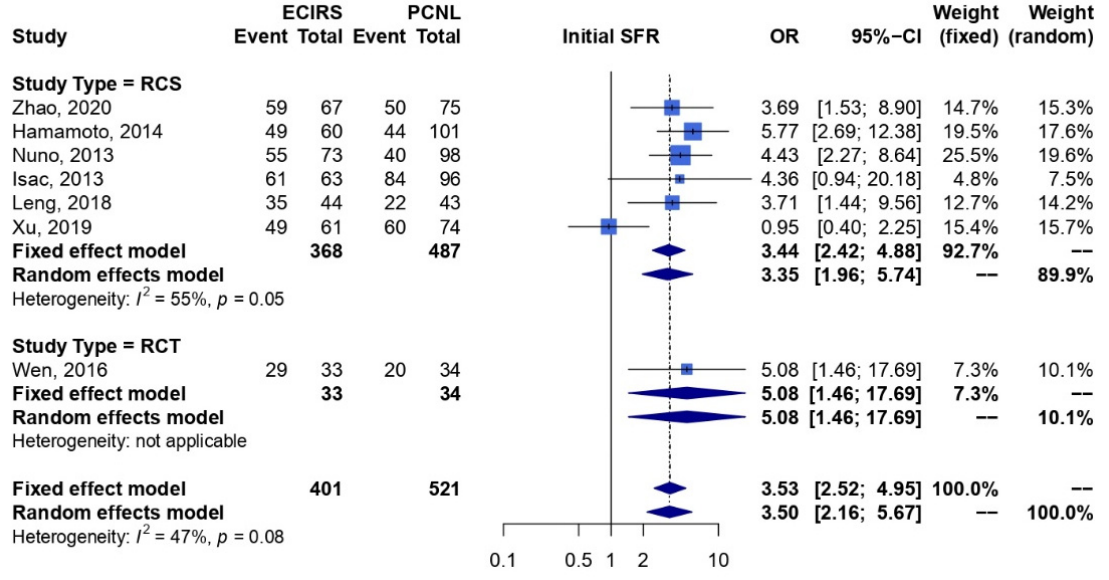
Figure A10. Subgroup analysis of outcome regarding initial stone free rate. (RCS: [18–23]; RCT: [17]).